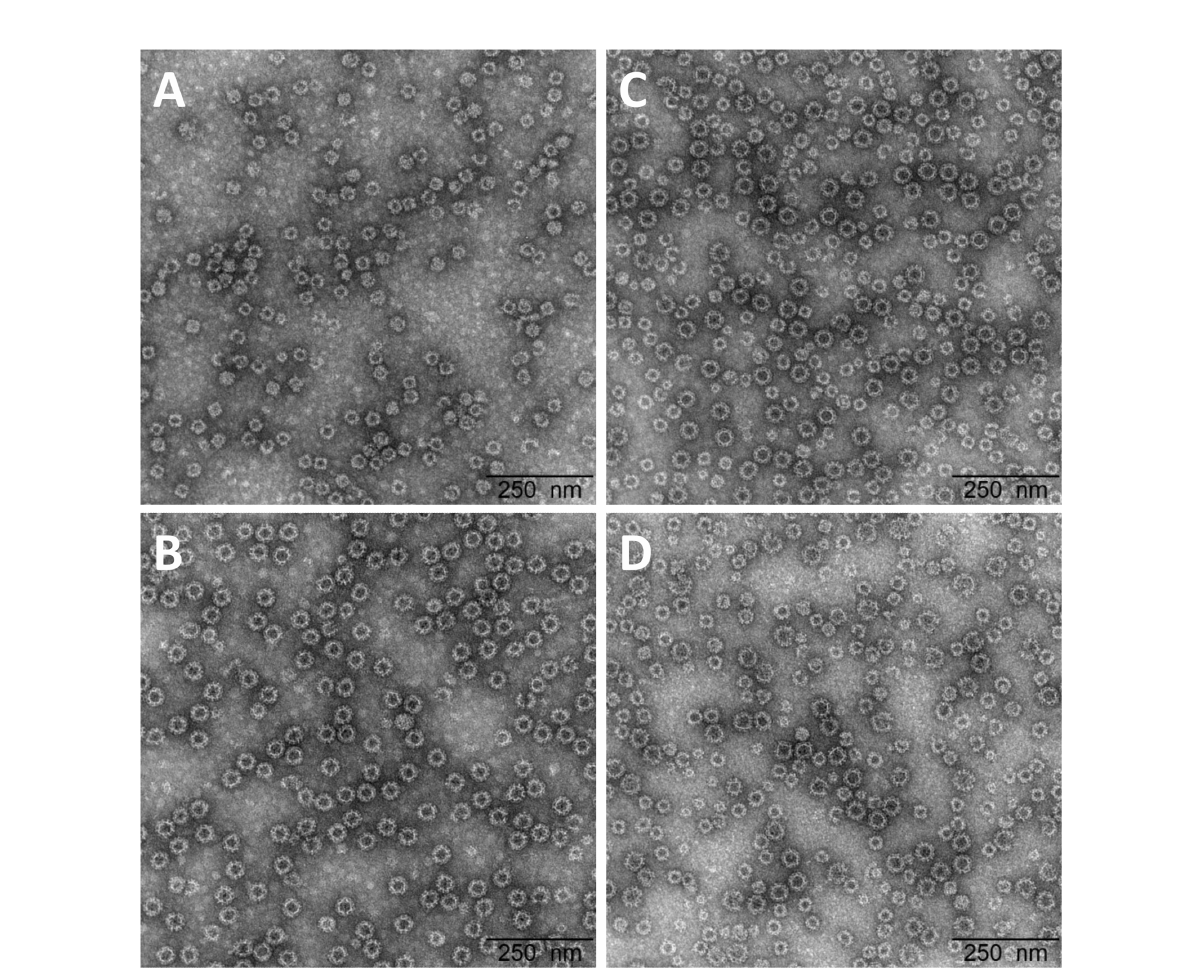
FIGURE 1 Electron micrographs of the highly puri fi ed, plant-produced, norovirus-like particles and vaccine formulations. VLPs formed by (A) GI.4 Chiba 407 (1987) capsid protein VP1 (batch IN003); (B) GII.4 Aomori 2 (2006) capsid protein VP1 (batch IN002); and formulated vaccine (1:1 mixture of both) at (C) 50 µg + 50 µg (batch IN004) and (D) 150 µg + 150 µg (batch IN005). Clinical batches were examined by transmission electron microscopy following negative staining with uranyless. The black bar corresponds to 250 nm. VLP, virus-like